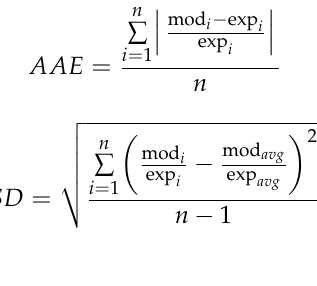
Figure 4. Typical failure modes.